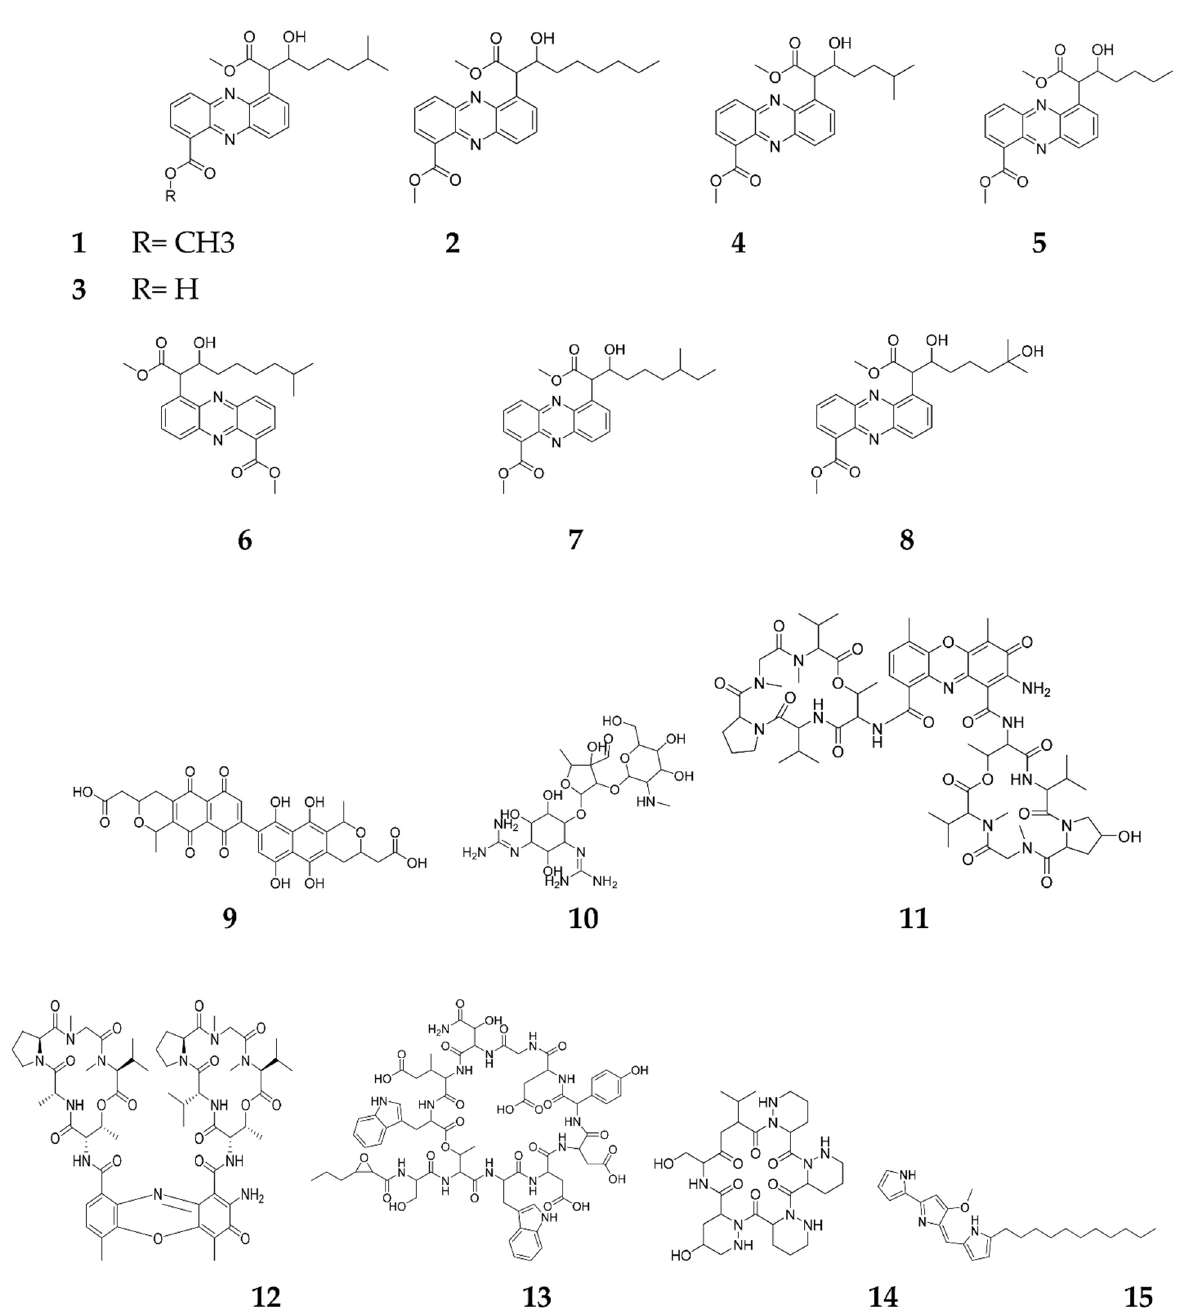
Figure 2. Secondary metabolites elicited by sub-inhibitory concentrations of